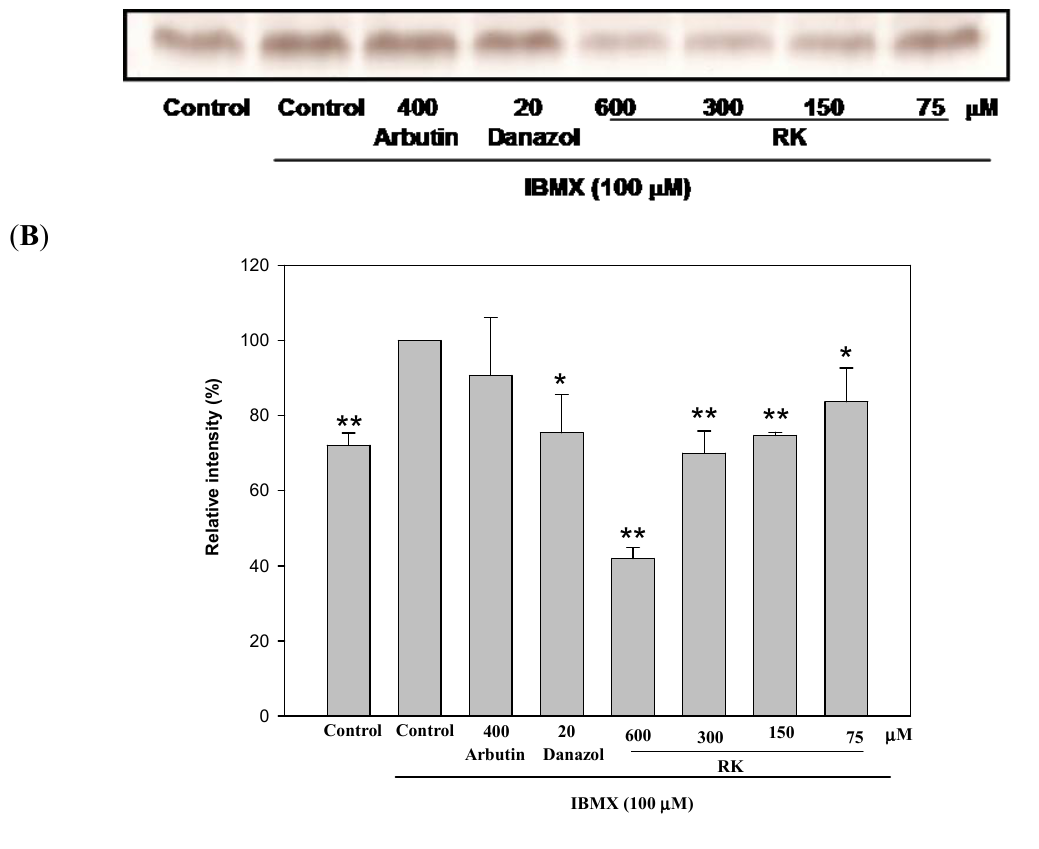
Figure 4. Evaluations of RK on the Effects on the Amounts of Tyrosinase Protein by Zymography ( A and B ) and Western blot ( C and D ) and Tyrosinase mRNA by qRT-PCR ( E ) in B16 Cells. Cells were inoculated in 24-well plates for 1 d and then stimulated by 100 µM IBMX with and without the test drug. They were harvested and the tyrosinase protein and mRNA were analyzed as described in the Experimental Section. The band intensities of tyrosinase from results of western blot and qRT-PCR were normalized by that of β -actin and GAPDH, respectively, and the normalized band intensity in the IBMX-stimulated control was recalculated to be 100. Averaged data (n = 4 for zymography and western blot; n = 7 for qRT-PCR) are presented with an error bar of SD. A value of p < 0.05 (*) or p < 0.001 (**) by Student’s t -test by comparing the data with that of the IBMX-stimulated control was considered statistically significant. ( A )